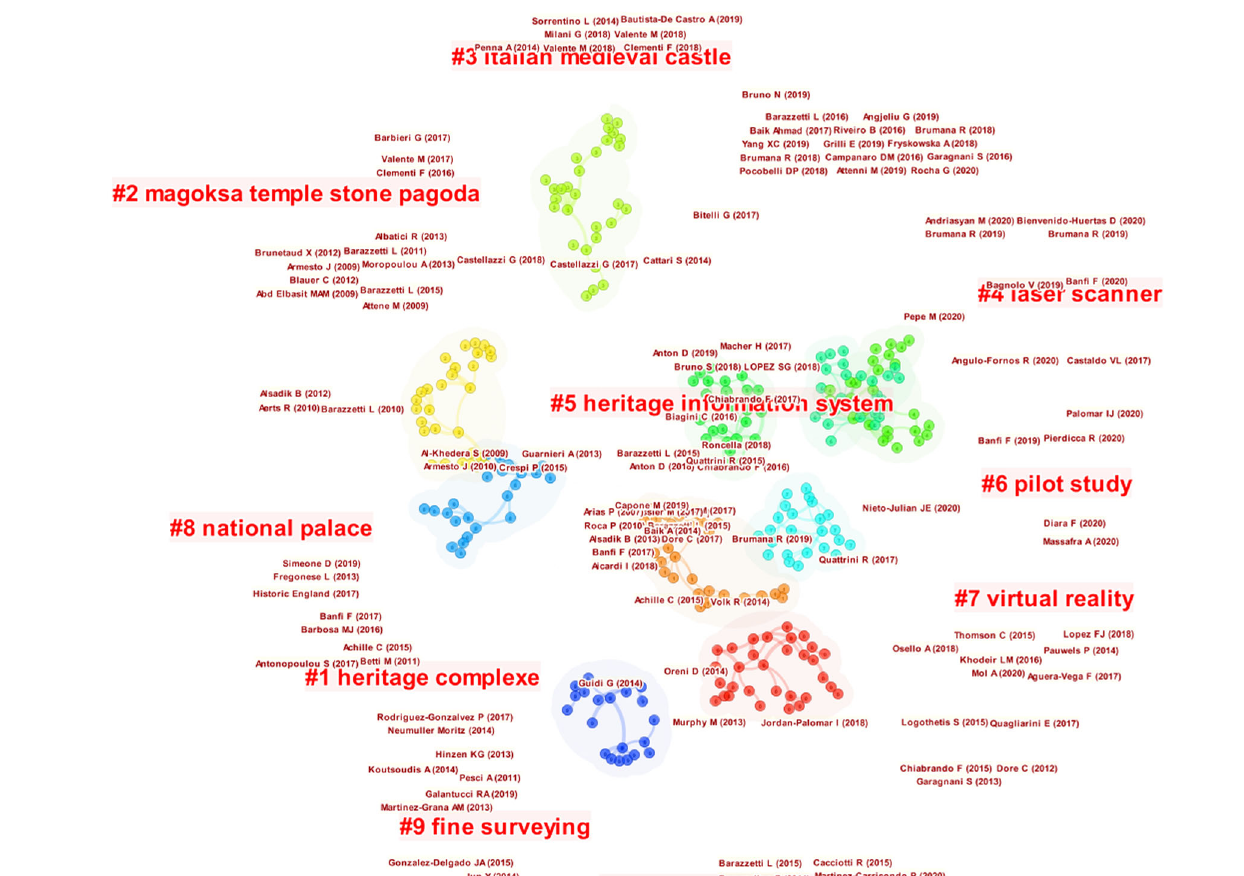
Fig. 8 Clustered view of literature co-citations. Clustered view of literature co-citations analyzed by CiteSpace bibliometric analysis software.